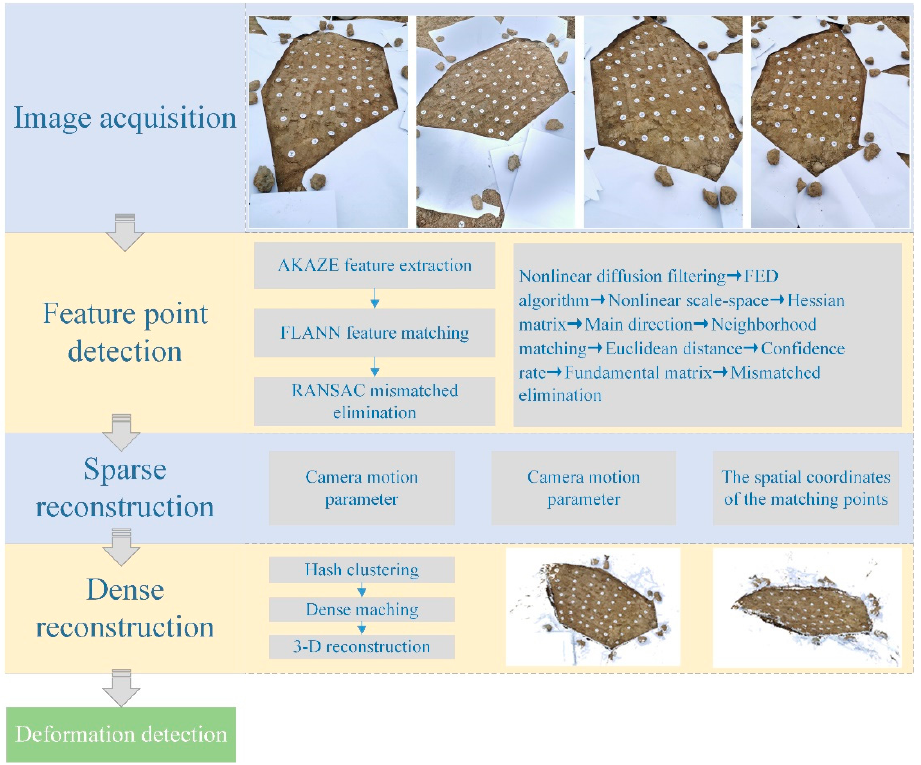
Table 2. Average number of effective feature points and accuracy of five types of operators.